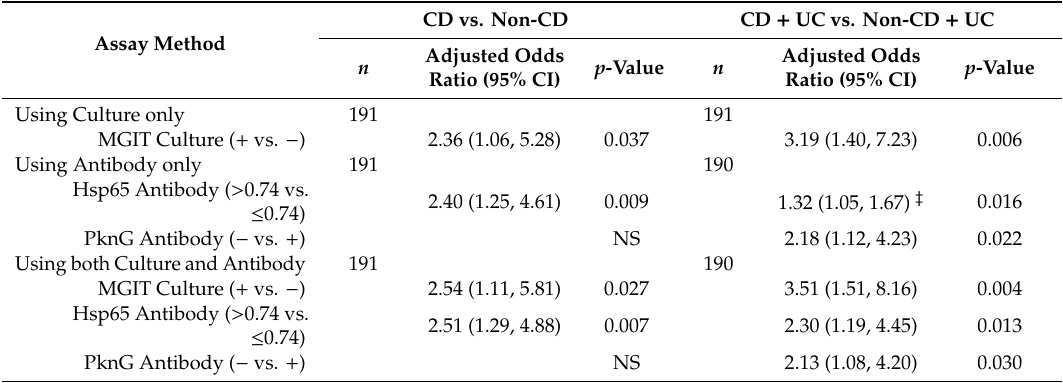
Table 5. Association analyses of MAP culture and serology with occurrence of select disease (CD or CD + UC) † .